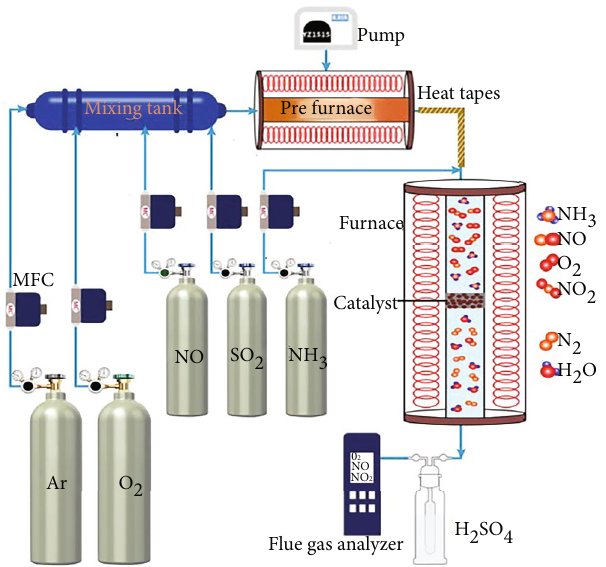
Figure 1: Schematic diagram of SCR experiments.